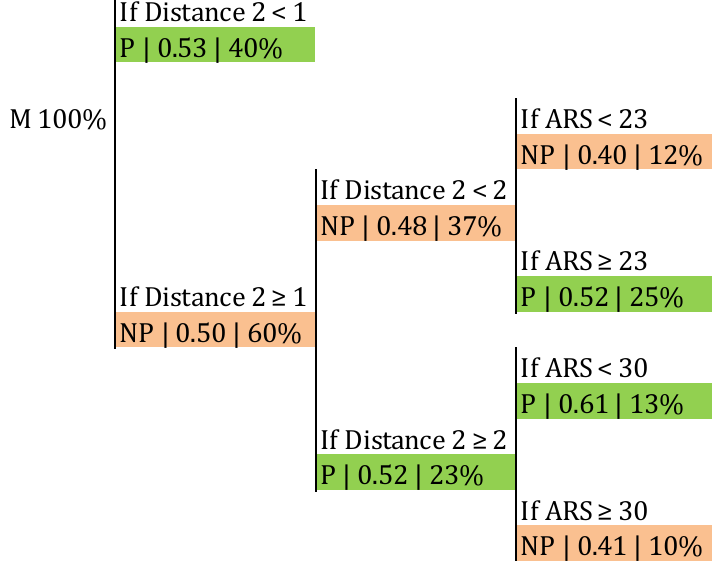
Figure 7. Probability of a point in male category in the side-out depending on Distance 2 and the ARS. ARS: angle described in the trajectory between APR and APS; P: point; NP: no point.